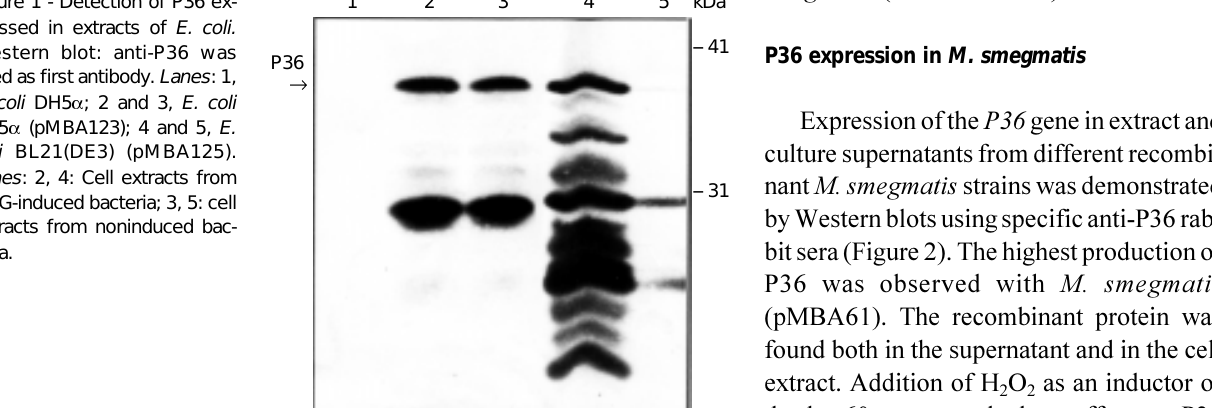
Figure 1 - Detection of P36 ex- pressed in extracts of E. coli. Western blot: anti-P36 was used as first antibody. Lanes : 1, E. coli DH5 a ; 2 and 3, E. coli DH5 a (pMBA123); 4 and 5, E. coli BL21(DE3) (pMBA125). Lanes : 2, 4: Cell extracts from IPTG-induced bacteria; 3, 5: cell extracts from noninduced bac-